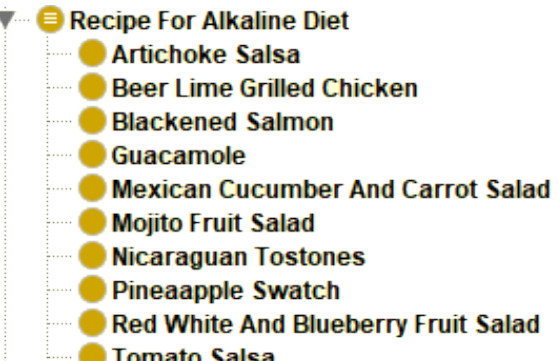
Figure 8. Recipes that comply with the Alkaline diet’s